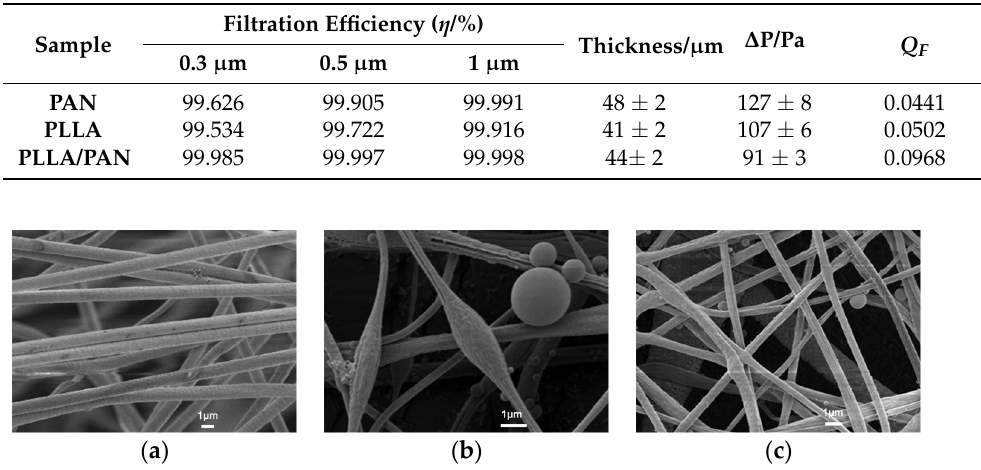
Table 1. Filtering effect of samples.